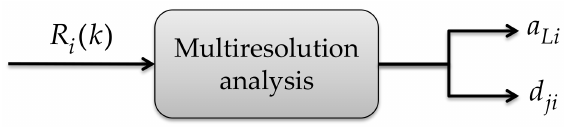
Figure 6. PSD decomposition through the MRA.